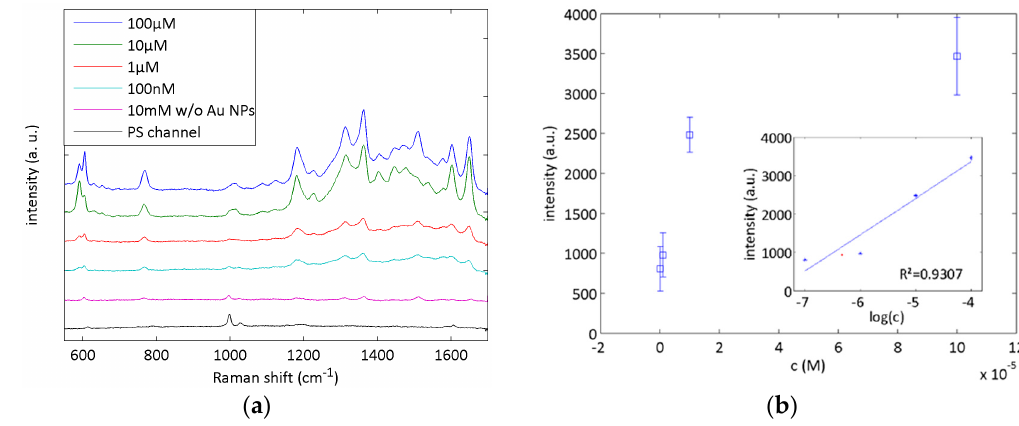
Figure 5. Microfluidic SERS analysis with Rh6G. Spectra of Rh6G solution at concentrations of 100 nM to 10 mM ( a ) were recorded with an acquisition time of 10 s and were averaged over 20 randomly chosen spots. The Raman peak at 780 cm − 1 was evaluated for quantitative analysis ( b ), showing a good linear relationship between intensity and logarithmic concentration as shown in the inset.